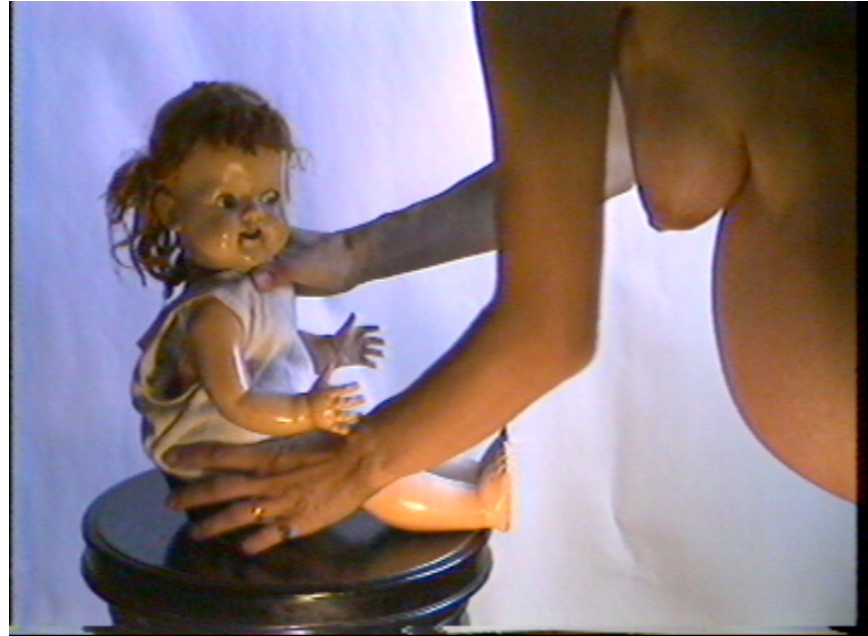
Figure 9: Cate Elwes With Child 1983. Video